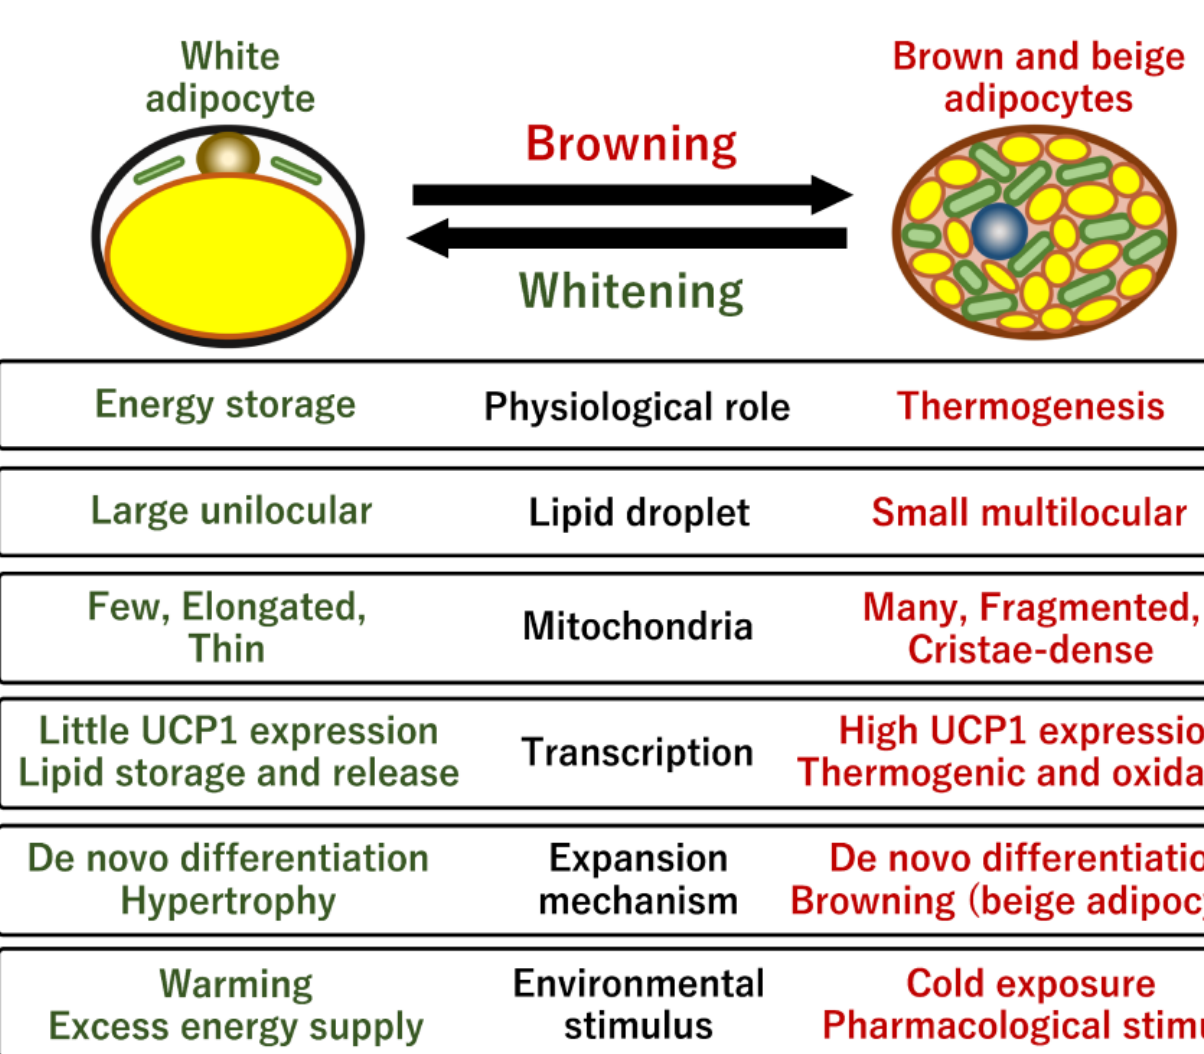
Figure 1. Comparison of characteristic features of white and brown adipocytes. The browning process promotes morphological change in lipid droplets, mitochondrial biogenesis, and transcriptional pro- gram for both mitochondrial oxidative respiration and thermogenesis. One of the most characteristic differences is that brown adipocytes possess enriched cristae-dense mitochondria containing a high level of iron, whereas white adipocytes possess relatively few elongated mitochond ria. Without a continuous cold stimulus, brown/beige adipocytes are phenotypically reversed into white-like adipocytes through a process termed whitening. Brown/beige adipogenesis occurs through both